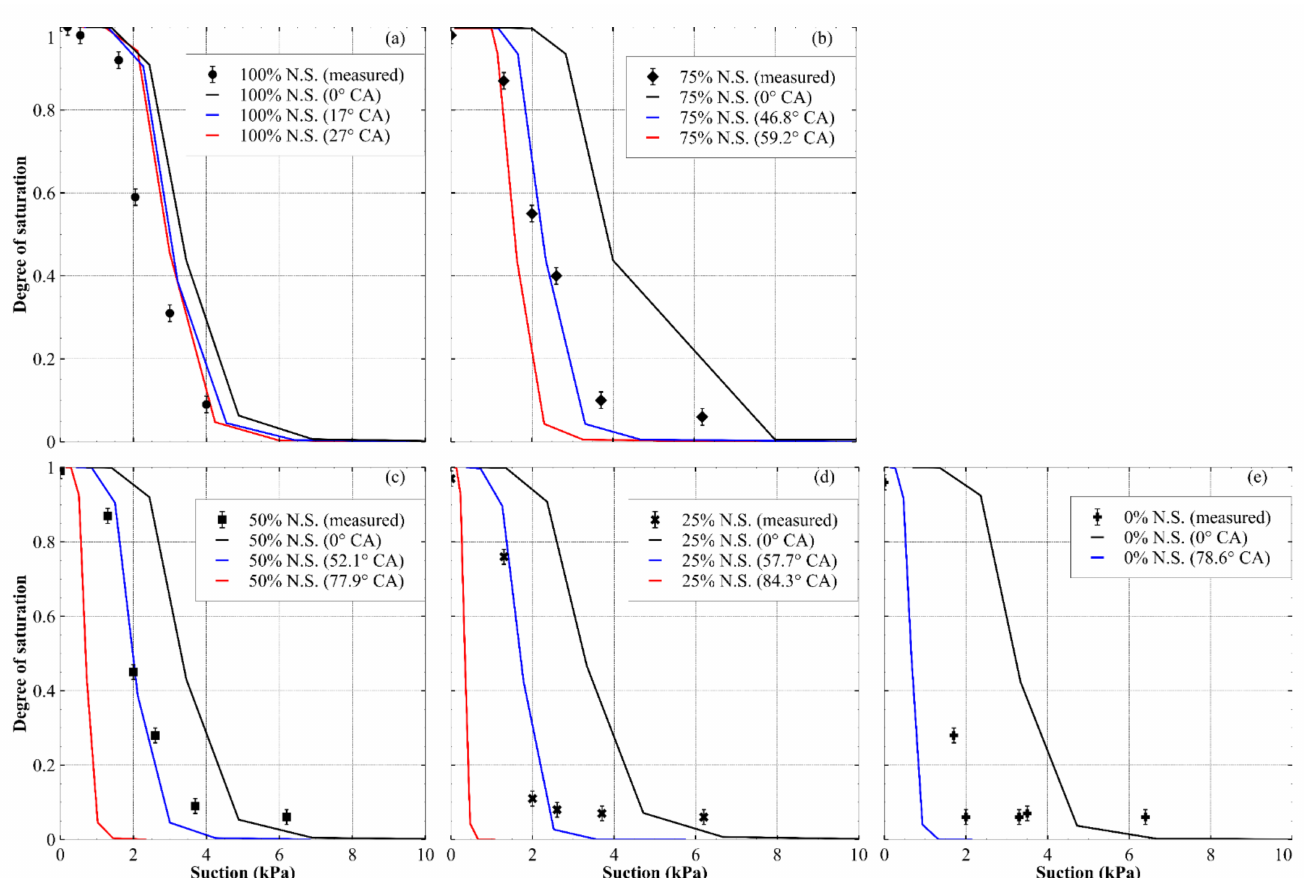
Figure 10. Predicted drying path of WRCs for sand and sand mixtures at different contact angles, expressed in terms of the degree of saturation vs. suction for ( a ) natural sand, ( b ) 75% natural sand and 25% hydrophobized sand, ( c ) 50% natural sand and 50% hydrophobized sand, ( d ) 25% natural sand and 75% hydrophobized sand and ( e ) 0% natural sand and 100% hydrophobized sand. For each prediction, CA values of 0 (black lines), CA mean − CA SD (blue lines) and CA mean + CA SD (red lines) were used. N.S. denotes natural